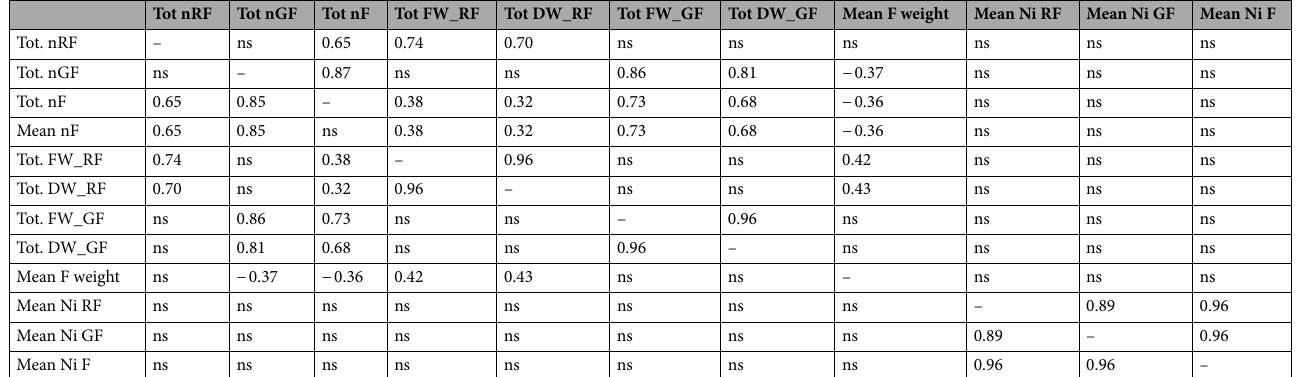
Table 1. Spearman’s rank order correlations. MD pairwise deleted Marked correlations are significant at P < 0.05. Tot. nRF total number of red fruits, Tot. nGF total number of green fruits, Tot. nF total number of fruits (red + green), Mean nF mean number of fruits produced, Tot. FW_RF total fresh weight of red fruits, Tot. DW_RF total dry weight of red fruits, Tot. FW_GF total fresh weight of green fruits, Tot. DW_GF total dry weight of green fruits, Mean F weight mean number of fruits weight, Mean Ni RF mean Ni concentrations in red fruit, Mean Ni GF mean Ni concentrations in green fruits, Mean Ni F mean Ni concentrations in fruits (red + green), ns not significant.